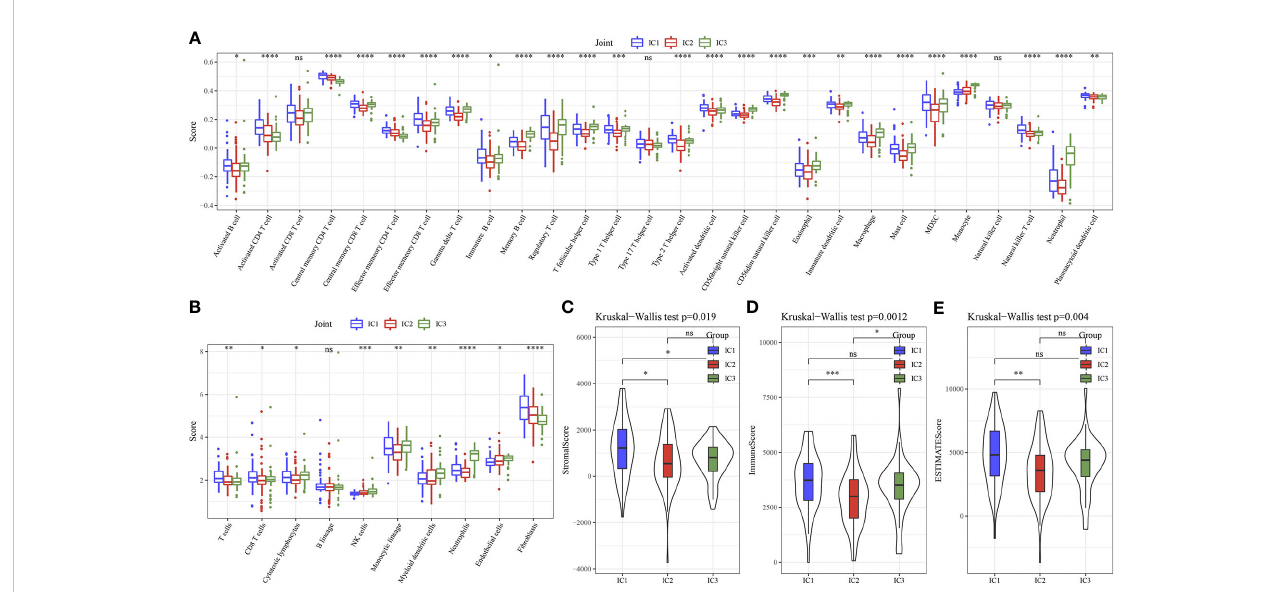
FIGURE 4 Immune characteristics of 3 molecular subtypes. (A) 28 immune cells scores differences of 3 molecular subtypes determined by ssGSEA. (B) 10 immune cells scores differences of 3 molecular subtypes determined by MCP-Counter. (C) StromalScore difference of 3 molecular subtypes determined by